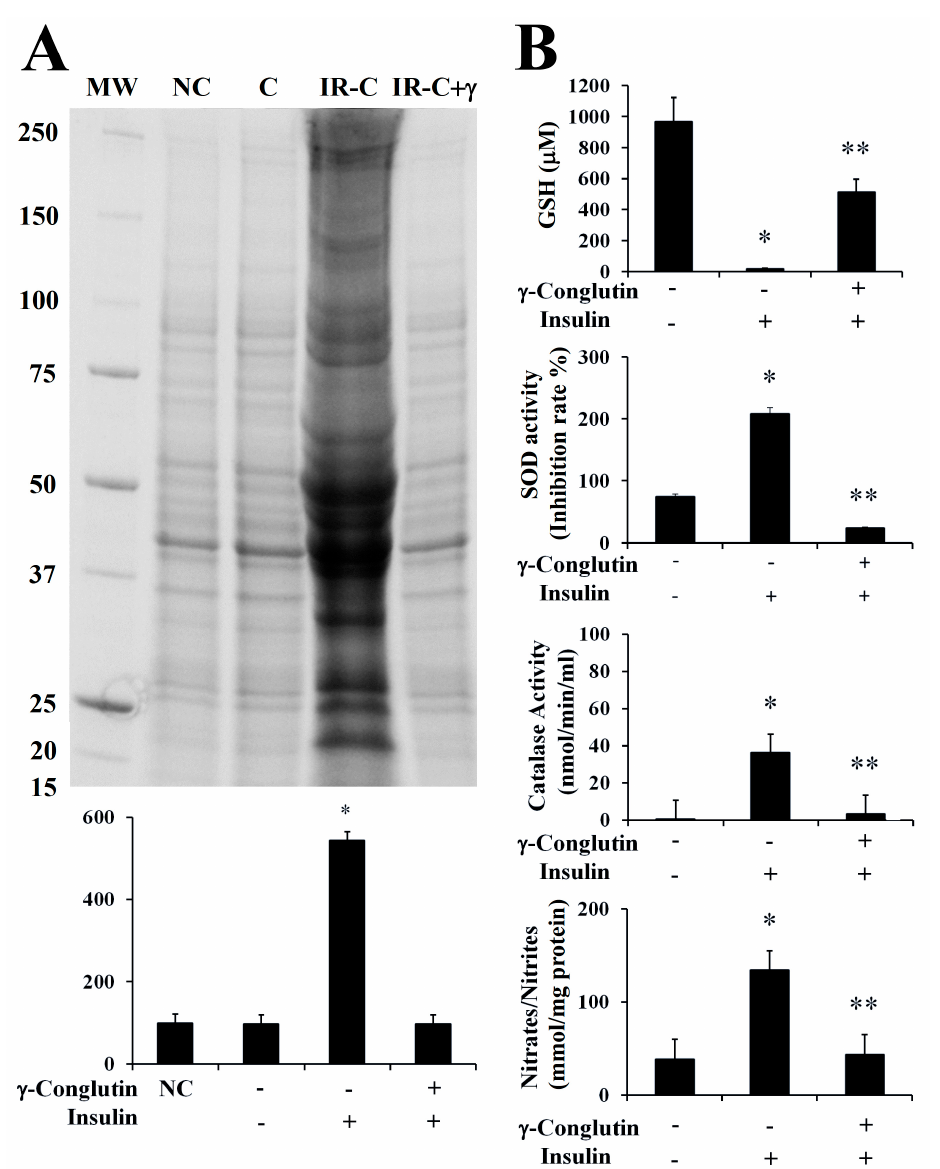
Figure 6. Effect of γ -conglutin on proteins oxidative modifications, antioxidant enzymatic activities and production of glutathione (GSH) and NO. ( A ) Changes in protein carbonyl formation were measured in IR-C cells after 24 h of incubation with γ -conglutin. Protein carbonyls were measured using an OxyBlot kit. Representative blots show basal carbonylation levels in C control PANC-1 cells, IR-C cells, and IR-C culture cells challenged with γ -conglutin. Graph y-axis represents arbitrary densitometry units. p * < 0.05 IR-C cells versus C cells. ( B ) IR-C pancreatic cells were incubated for 24 h with γ -conglutin protein. GSH and NO production, as well as SOD and catalase activities were measured. Data represent mean ± SD from three independent experiments. p < 0.05 represents statistically significant differences associated with each figure. p * < 0.05 IR-C versus control PANC-1 cells; p ** < 0.05 IR-C + γ -conglutin versus IR-C. Challenges were made with 25 μ g of γ -conglutin.